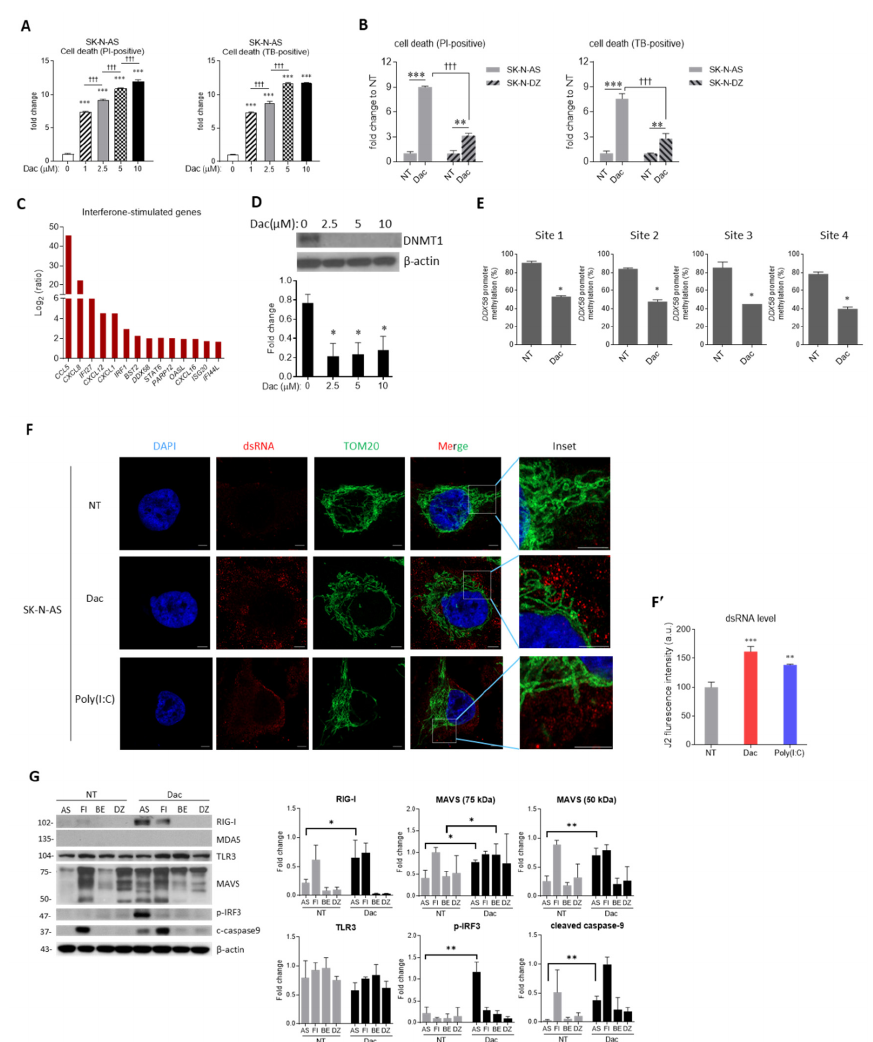
Figure 1. 5-aza-2 ′ -deoxycytidine (Dac) preferentially induces a retinoic acid-inducible gene I (RIG-I)-predominant innate immune response and cell apoptosis Human NB cells (SK-N-AS). ( A ) SK-N-AS cells were treated with Dac from 0 to 10 µ M for 5 days. Cell death was determined using propidium iodide (PI) and trypan blue (TB) staining with the flow cytometry. † p < 0.05, ††† p < 0.001 between indicated groups; ( B ) cell death of human NB cell lines SK-N-AS and SK-N-DZ cells treated with 2.5 µ M Dac for 5 days; ( C ) SK-N-AS cells treated with 2.5 µ M Dac or untreated control (NT) for 5 days were harvested and subjected to microarray analysis. Histogram showing up-regulated interferon-stimulated genes; ( D ) representative western blot of DNA methyltransferase 1 (DNMT1) and densitometric data; ( E ) SK-N-AS cells were treated with or without 2.5- µ M Dac or NT for 5 days. Methylation level of four CpG sites at the DDX58 / RIG-I promoter; ( F ) SK-N-AS cells were treated with 2.5- µ M Dac or NT for 5 days. Representative immunofluorescent image of dsRNA (red), mitochondrial outer membrane marker TOM20 (green) and DAPI-stained nuclei (blue). Poly(I:C), a synthetic analog of dsRNA, was used as positive control. Scale bar, 5 µ m. Insets contain magnified images highlighting mitochondria and dsRNA. Note that Dac treatment causes an increased level of dsRNA in cytoplasm. ( F’ ) percentage of J2 fluorescence intensity (a.u., arbitrary unit) was quantified (representative images shown in Supplementary Figure S3B) under relatively lower magnification (100X) of an Olympus FV10i confocal microscope; ( G ) representative western blot result of proteins related to innate immune response and apoptotic signaling in various NB cells with (BE and DZ) or without (AS and FI) MYCN amplification. β -actin serves as loading control. Data shown as mean ± SD. * p < 0.05, ** p < 0.01 *** p < 0.001 when compared to 0- µ M or NT group.